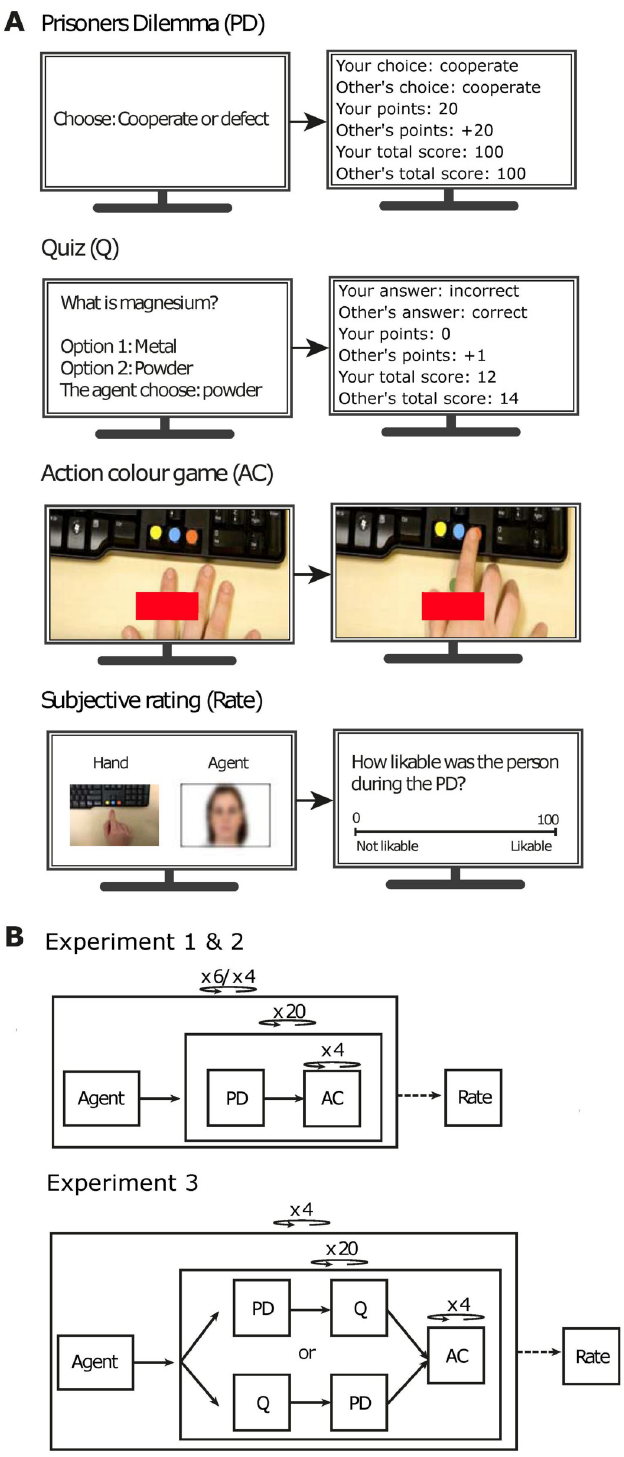
Fig 1. Stimuli and procedures. The figures represent a reconstruction of the displays shown to the participants during the games. In the prisoner’s dilemma game (PD; top panel in A) the participant chose between cooperate and defect, and then obtained an overview of the agents choice and how this affected their rewards. In experiment 3, participants also participated in a quiz (Q; second panel in A), choosing an answer from two answer options per question, and knowing the agent’s answer in advance. In the action color game (AC; third panel in A) participants saw the video of